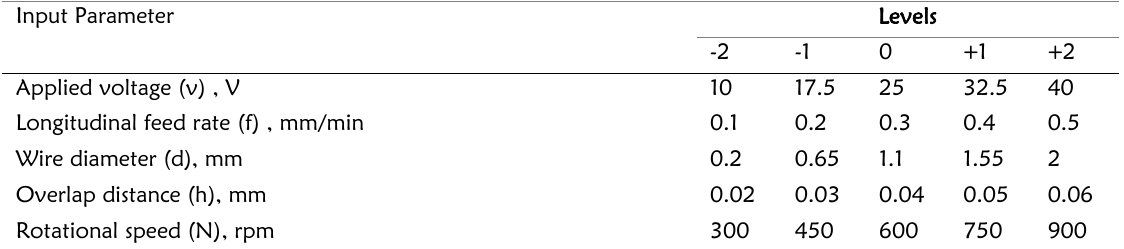
Table 2: DoE factors levels in WECT